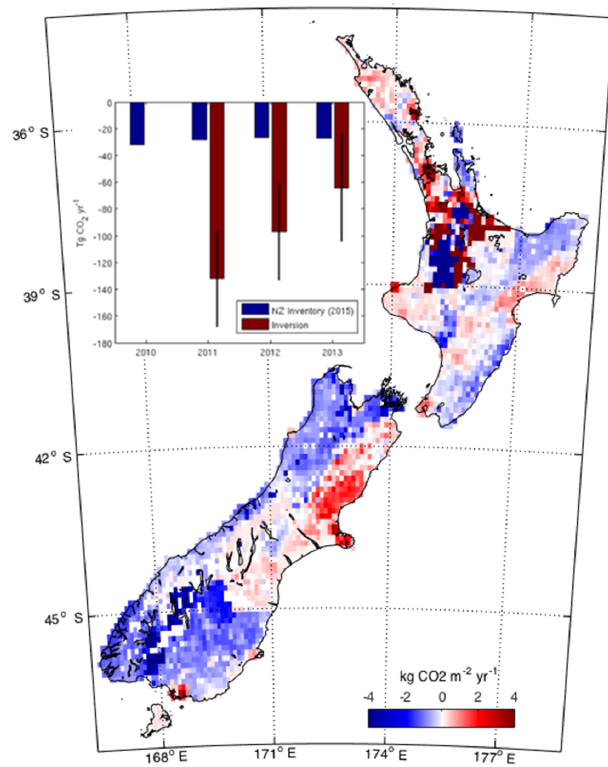
Figure 11. Geographic distribution of land-to-air CO 2 flux, aver- aged over 2011–2013. Blue and red regions indicate net carbon up- take and release, respectively. Per-area ocean fluxes are too small to show on this scale. Fossil fuel emissions are included and reach up to 20kgCO 2 m − 2 yr − 1 in a few grid cells (Auckland area). The colour scale is capped to focus on natural fluxes. Inset: annual mean results compared to the National Greenhouse Gas Inventory